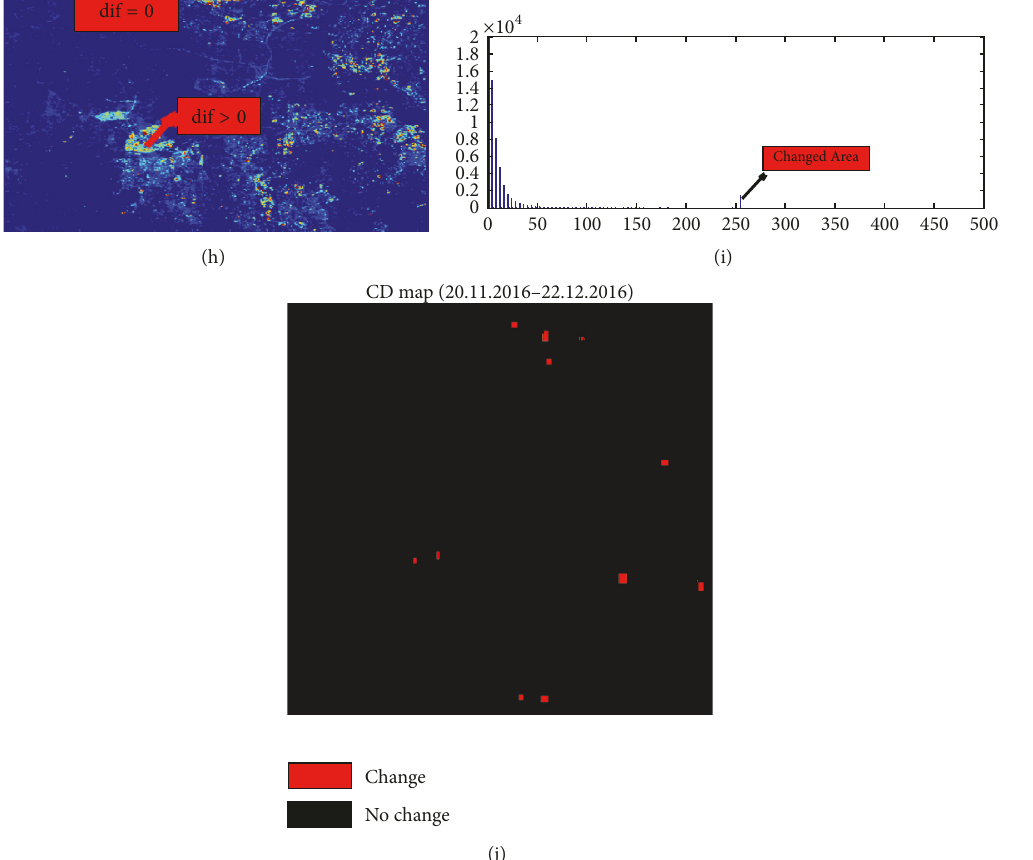
Figure3:ExperimentalimagesandchangemapbyOTSUthresholdselection.(a)Referenceimage:2000.(b)Targetimage:2001.(c)Difference image. (d) Histogram of difference image. (e) Corresponding binary change map. (f) Reference image: 20.11.2016. (g) Target image: 22.12.2016. (h) Difference image. (i) Histogram of difference image. (j) Corresponding change map.